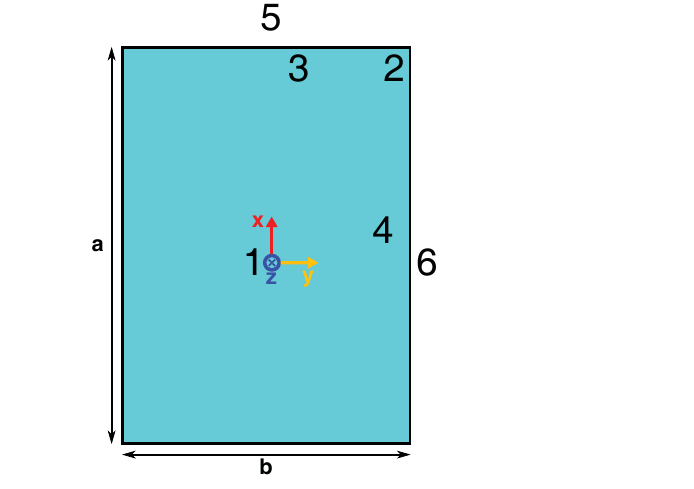
Figure 2. Position of the test lines into the bag. Exact positions are reported in Table 1. Table 1. Segment positions.